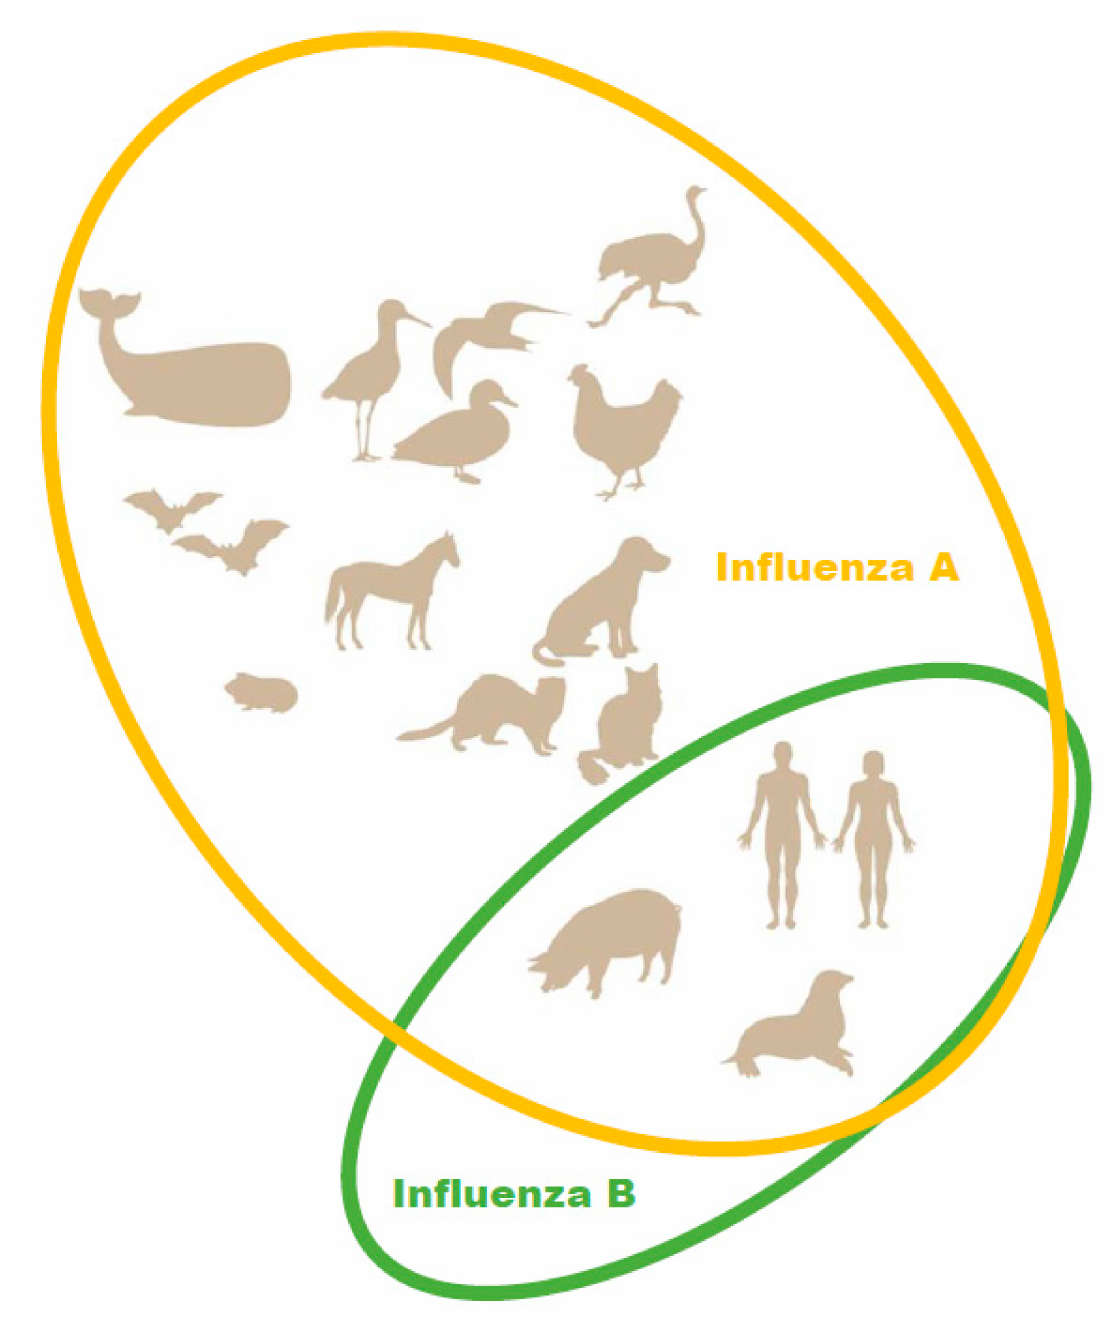
Figure 1. Natural hosts of influenza A and B